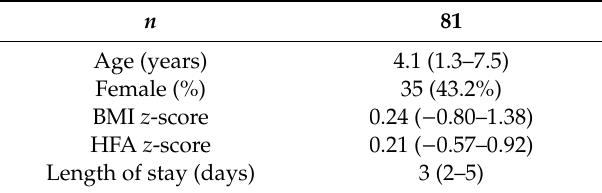
Table 1. Characteristics of patients that completed the